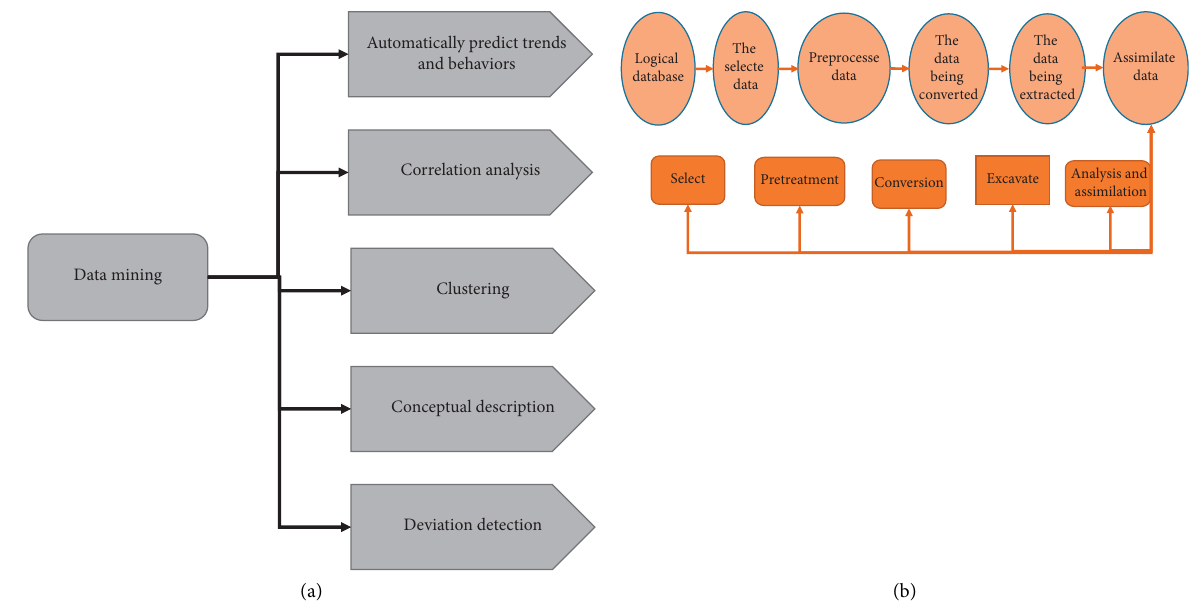
Figure 2: DM functions and fowcharts. (a) DM feature diagram. (b) DM